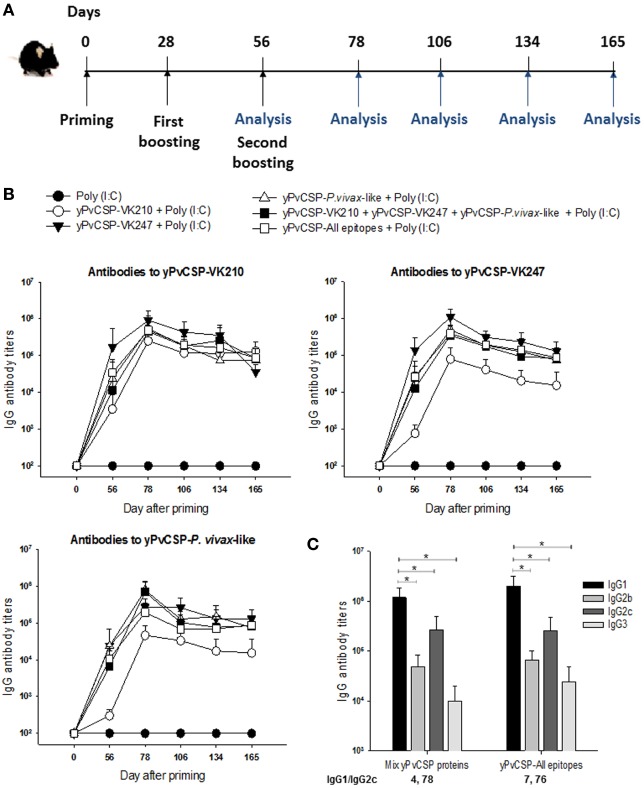
Specific antibody response in mice immunized with Plasmodium vivax circumsporozoite protein (PvCSP) recombinants. (A) C57BL/6 mice were immunized s.c. with three doses 28 days apart with the purified proteins in the presence of the adjuvant Poly(I:C), whereby the antibody response was analyzed according to the timeline described. (B) The IgG antibody serum titers against recombinant proteins representing each allelic form of PvCSP were analyzed by ELISA. The results are expressed as the means ± SD (n = 6). Mouse groups were immunized with: (1) Poly(I:C); (2) Poly(I:C) plus yPvCSP-VK210 (1 μg/dose/mouse); (3) Poly(I:C) plus yPvCSP-VK247 (1 μg/dose/mouse); (4) Poly(I:C) plus yPvCSP-P. vivax-like (1 μg/dose/mouse); (5) Poly(I:C) plus a protein mix [yPvCSP-VK210 (1 μg/dose/mouse) + yPvCSP-VK247 (1 μg/dose/mouse) + yPvCSP-P. vivax-like (1 μg/dose/mouse)]; or (6) Poly(I:C) plus yPvCSP-All epitopes (3 μg/dose/mouse). (C) IgG isotypes were determined by ELISA in sera of mice from groups 5 and 6 described above. Asterisk denotes statistical differences (P < 0.01) when comparing IgG1 isotype with IgG2b, IgG2c and IgG3.